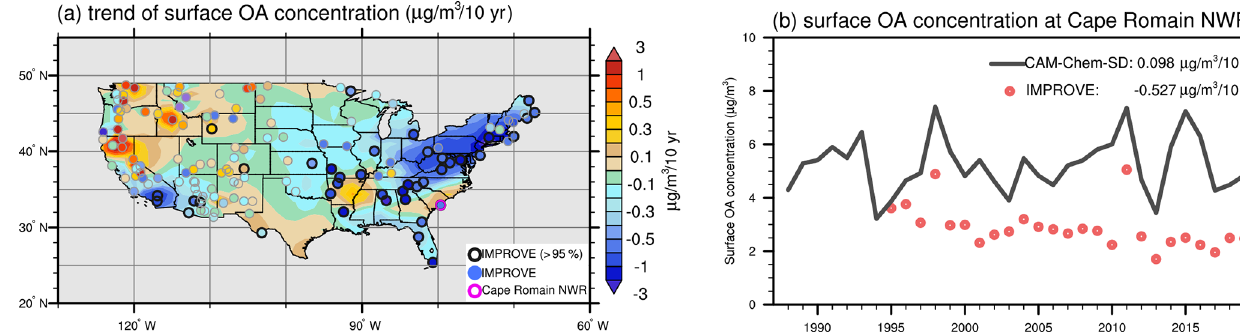
Figure 7. The 1988–2019 JJA (a) simulated surface OA decadal trend and IMPROVE surface OA decadal trend at selected IMPROVE sites (filled circles). Black circles indicate sites with statistically significant trends with 95% confidence according to Student’s t test; (b) simulated (black lines) and observed (red dots) surface OA concentrations at Cape Romain NWR site (shown as purple circle in Fig. 7a). Simulated and observed OA decadal trends (unit: µgm − 3 per 10 years) in summer at the site are shown as the numbers in the